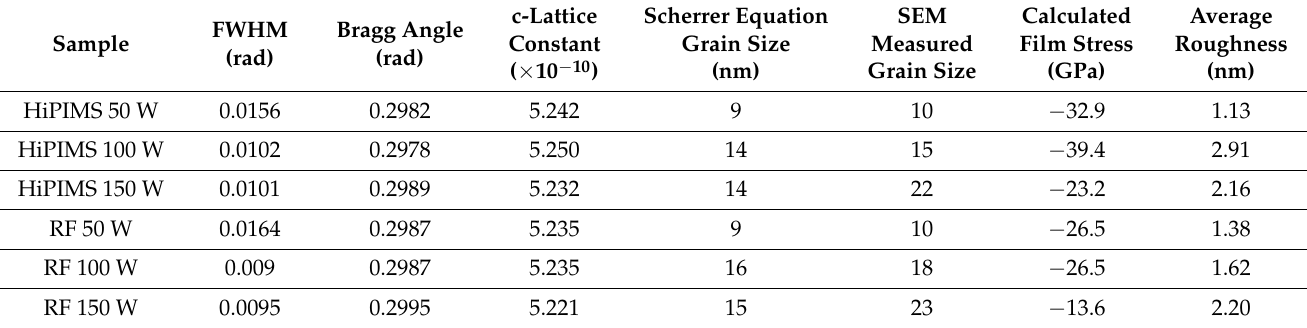
Table 2. Table of XRD, SEM, and AFM summary of data.